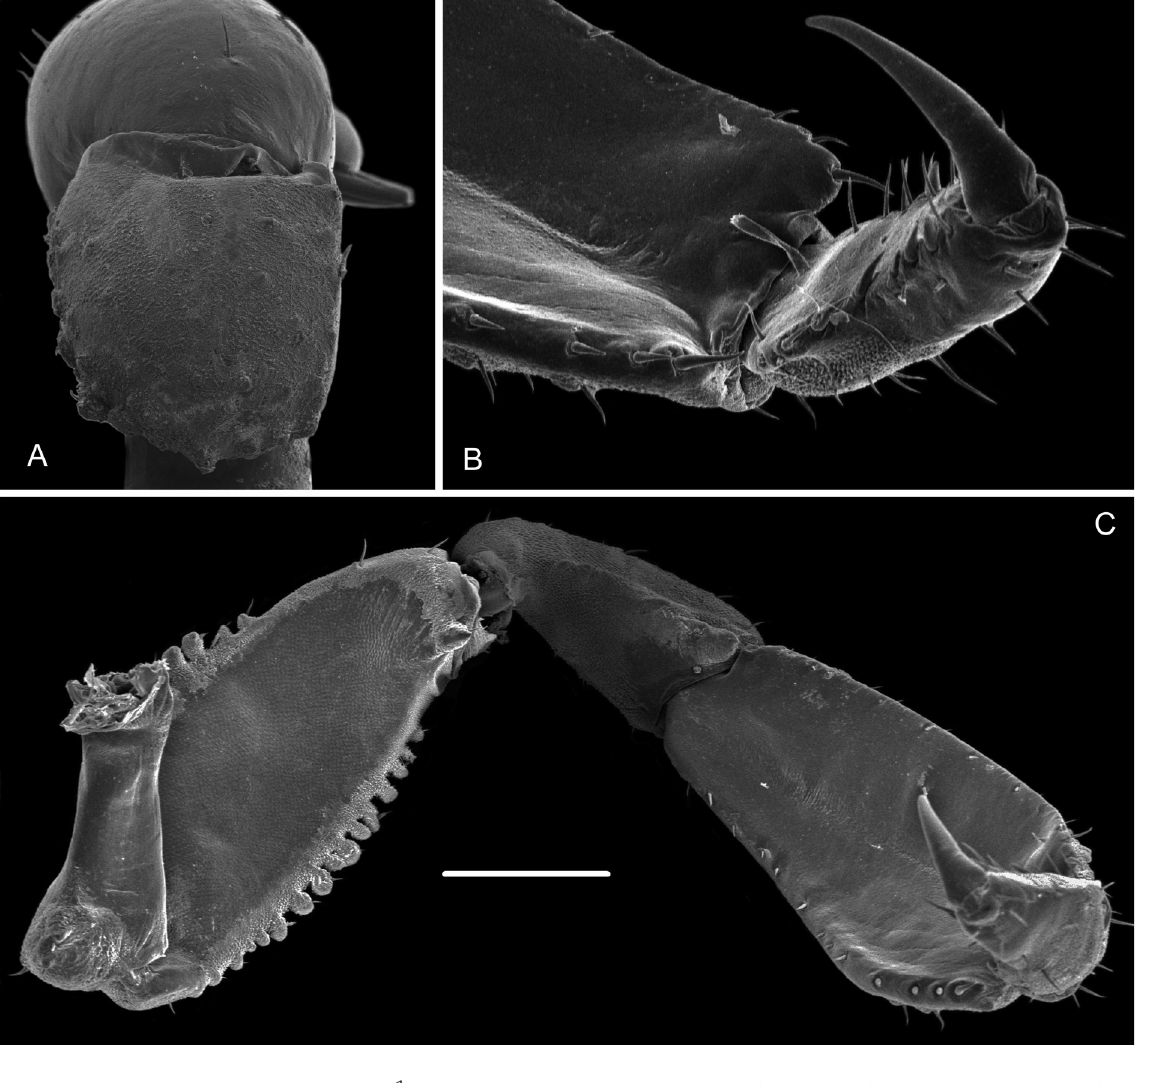
Fig. 13. Eulibitia helena sp. nov., ♂, paratype (IAvH 38). A . Left chelicera, dorsal view. B . Detail of tarsus and tarsal claw of left pedipalpus, ventro-apical view. C . Left pedipalpus, mesal view. Scale bars: A = 200 µm; B–C = 500